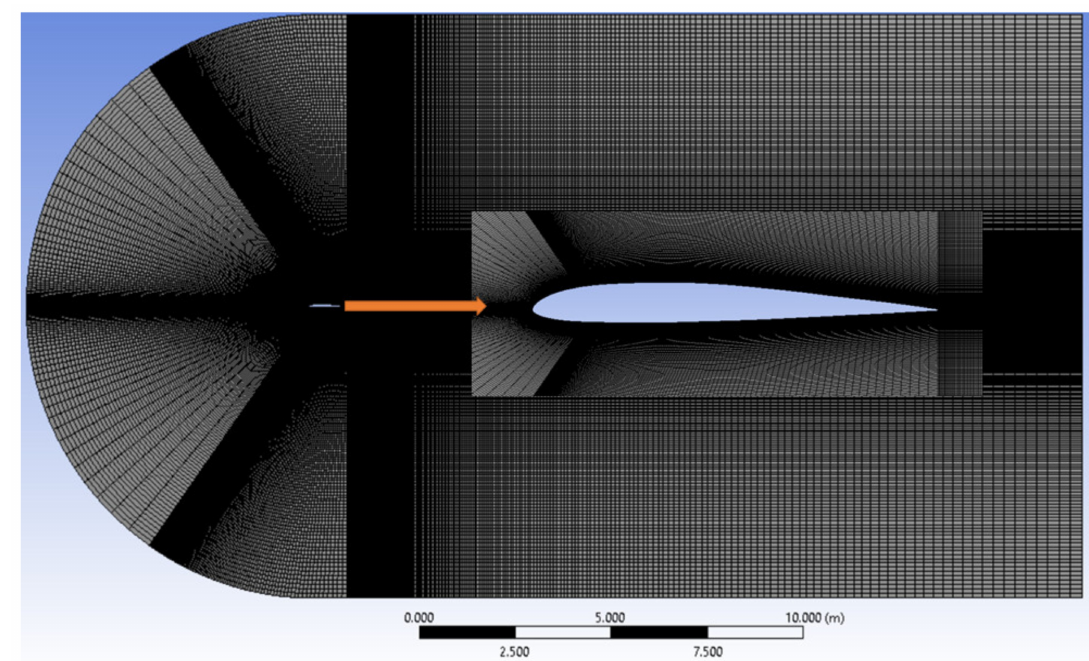
Figure 4. Grid around the airfoil used in Reynolds-averaged Navier–Stokes (RANS)